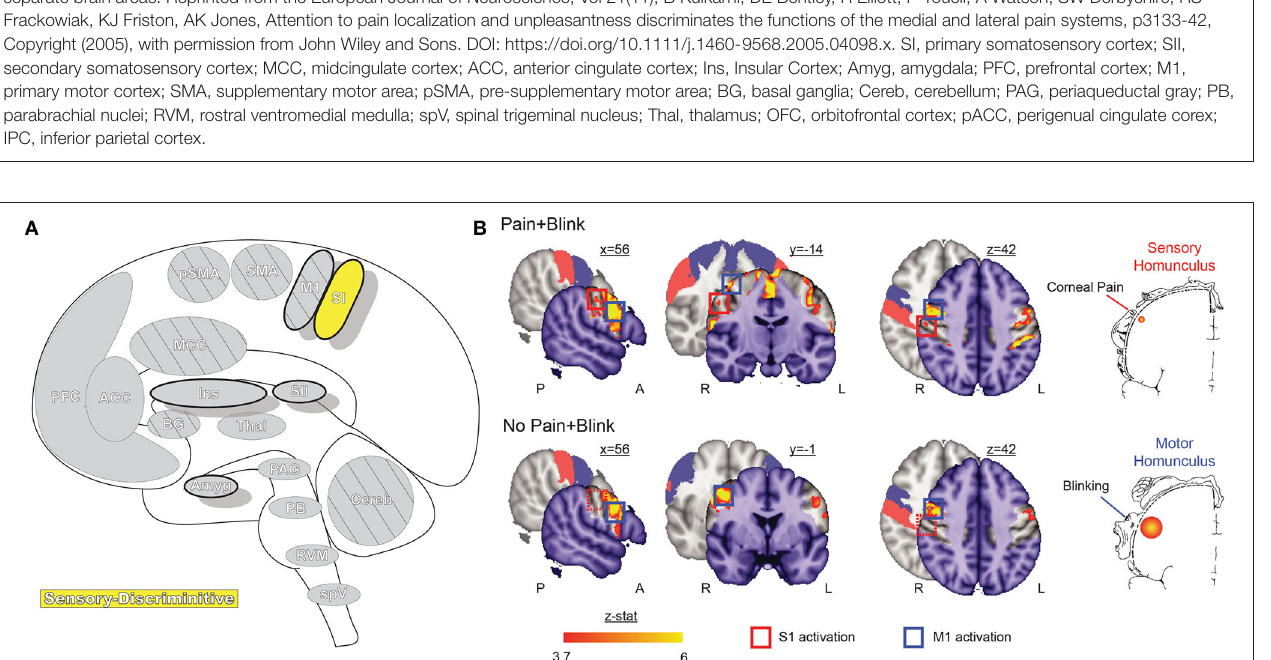
FIGURE 2 | increase from 1 to 15 with increasing convergence across 15 total main effects meta-analyses that each reflect pain-related activation. Reprinted from Neuroscience & Biobehavioral Reviews, Vol 112, A Xu, B Larsen, EB Baller, JC Scott, V Sharma, A Adebimpe, AI Basbaum, RH Dworkin, RR Edwards, CJ Woolf, SB Eickhoff, CR Eickhoff, TD Satterthwaite, Convergent neural representations of experimentally-induced acute pain in healthy volunteers: A large-scale fMRI meta-analysis, p300–23, Copyright (2020), with permission from Elsevier. https://doi.org/10.1016/j.neubiorev.2020.01.004. (B) Schematic of brain areas related to the processing of the multidimensional experience of pain. Each region is color coded to correspond to its hypothesized dimension of pain, while hatch-marks indicate processing associated with pain-related movement. Thick black borders indicate regions located more lateral to the midline. Relative size of each region is roughly proportional for structures larger than SII. (C) Attention to different features of a painful stimulus can shift activation patterns. Focusing on the unpleasantness of pain vs its location results in different patterns of brain activation when examined by PET, providing evidence that the unique dimensions of pain may be processed in separate brain areas. Reprinted from the European Journal of Neuroscience, Vol 21(11), B Kulkarni, DE Bentley, R Elliott, P Youell, A Watson, SW Derbyshire, RS Frackowiak, KJ Friston, AK Jones, Attention to pain localization and unpleasantness discriminates the functions of the medial and lateral pain systems, p3133-42,